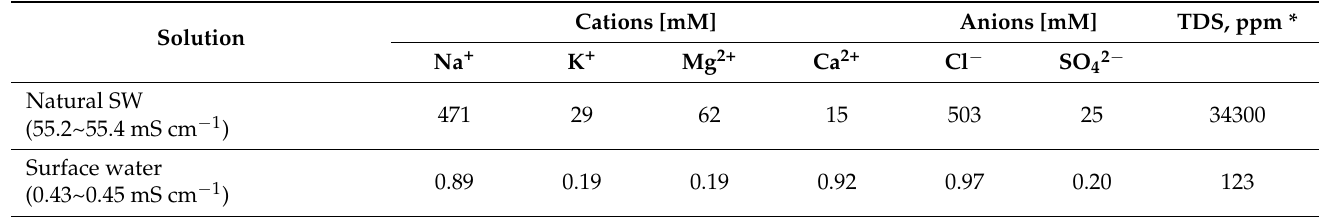
Table 2. Ion composition in natural SW and surface